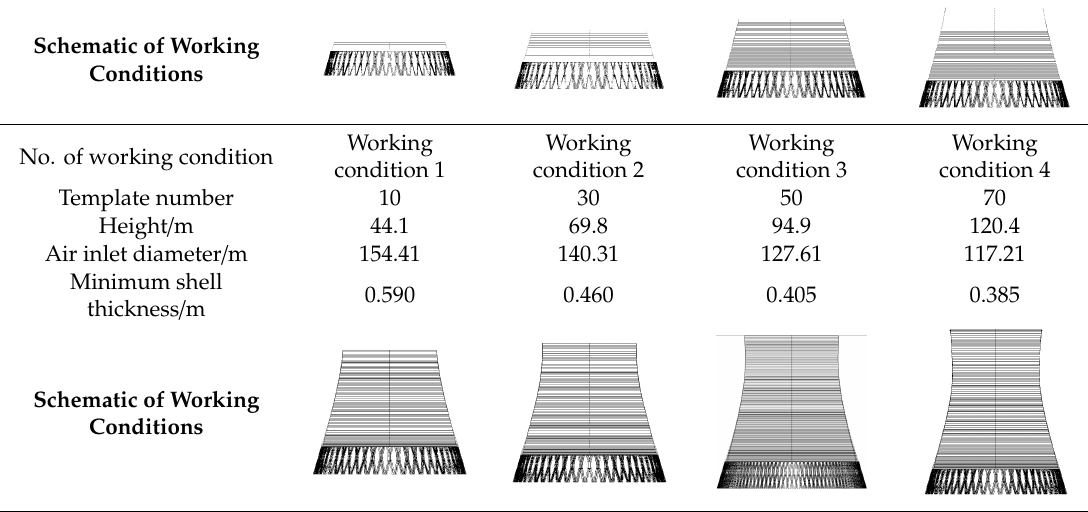
Table 2. Parameters of super large cooling tower under typical working conditions.